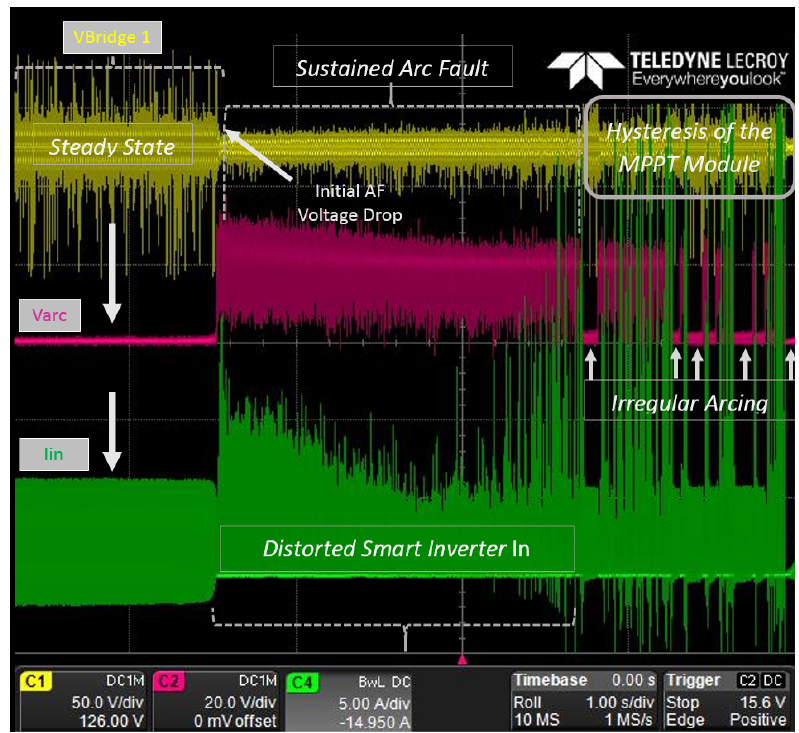
Figure 16. Experimental results of arcing before the MPPT module. The AF esd generated in the main DC bus and signals were acquired across a time length of 5 s. In VBridge 1, an initial drop in voltage is observed when the AF ignites; this drop is proportional to the AF sustained voltage. V arc remains constant until the MPPT controller begins to compensate the loss in VBridge 1 caused by the arc. Although the MPPT control module will attempt to keep the output at the nominal 40 V, the regulation is not successful since the fault surpasses the elevation capabilities of the converter. This means that, after reaching the MPPT operation limit, it will follow the aleatory